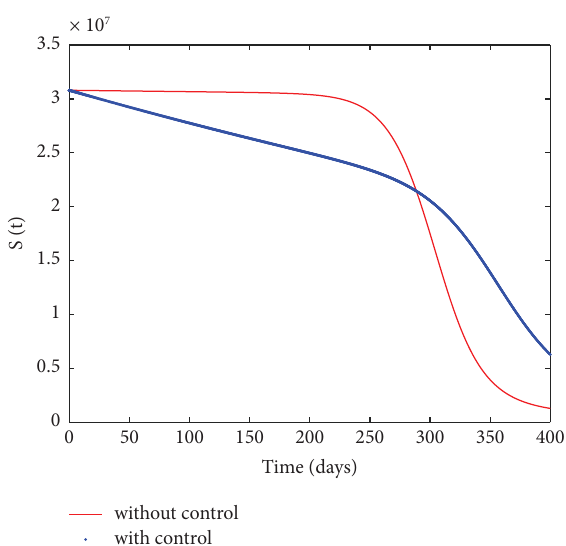
Figure 16: Behaviour of the susceptible individuals with and without the vaccination control.